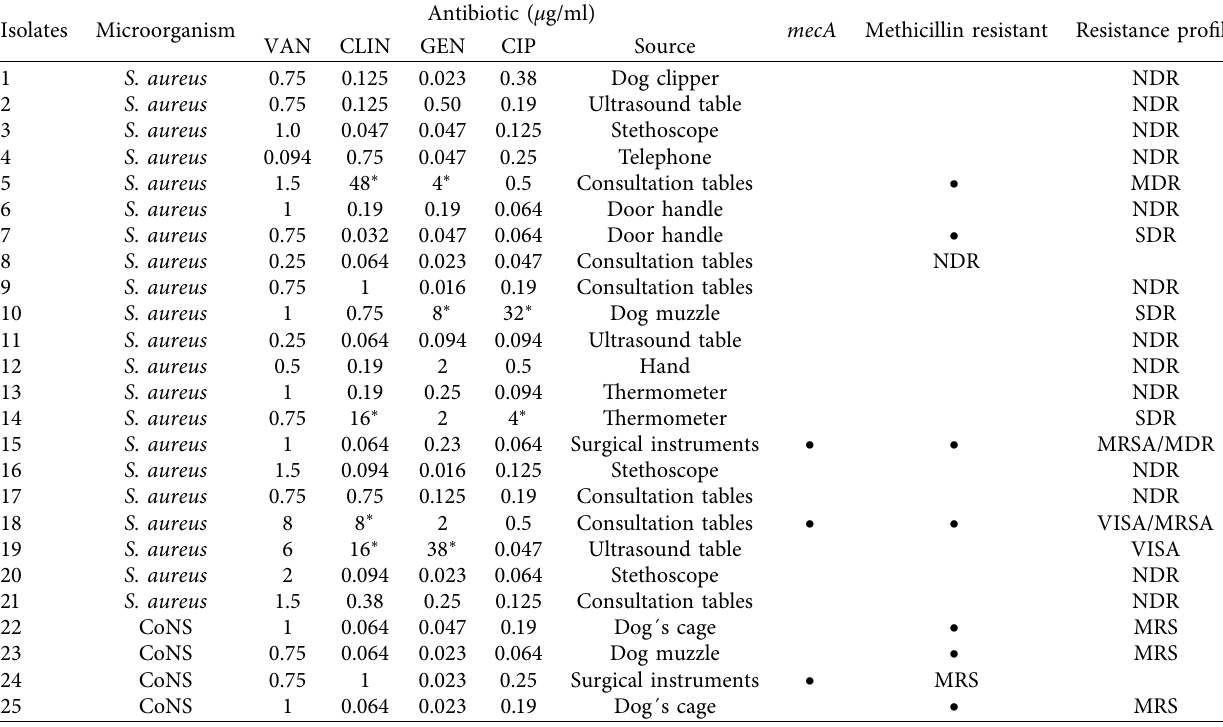
Table 1: Pathotypes and minimum inhibitory concentration (MIC) of coagulase-negative Staphylococci (CoNS) and S. aureus .